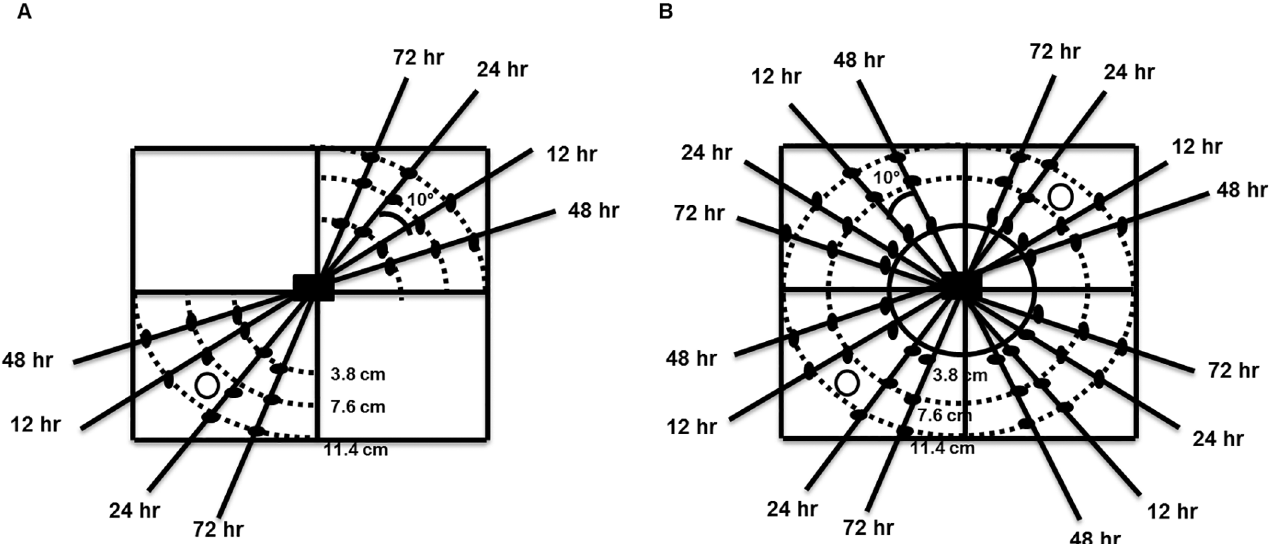
Fig 1. Experimental design. A pictorial representation of the experimental design showing 0.05 m 2 sized microcosm used for studying dispersal of infective juveniles (IJs) emerging from the source nematode-infected cadaver (black rectangle) placed in the center in the presence of a non-mobile host ( Galleria mellonella larva in a wire mesh cage) ( A ) and mobile hosts ( G . mellonella larvae) ( B ). Each microcosm was divided into four quadrants. Host insects released in the microcosm are represented by empty circles. Soil cores samples were collected from 2 cm wide arcs (dotted lines) in the microcosms containing non- mobile host at different distances marked by black spots and at different time intervals depicted by the transects running through the microcosms at 12, 24, 48 and 72 hr, and then baited with live G . mellonella larvae in plastic cups (30 ml) to recover the dispersed IJs. Similarly, soil core samples were collected from 2 cm wide annuli (dotted circles) at different distances starting from the outer edge of the wire-mesh cylinder (bold circle) and at different time intervals in the microcosms with and without mobile hosts.